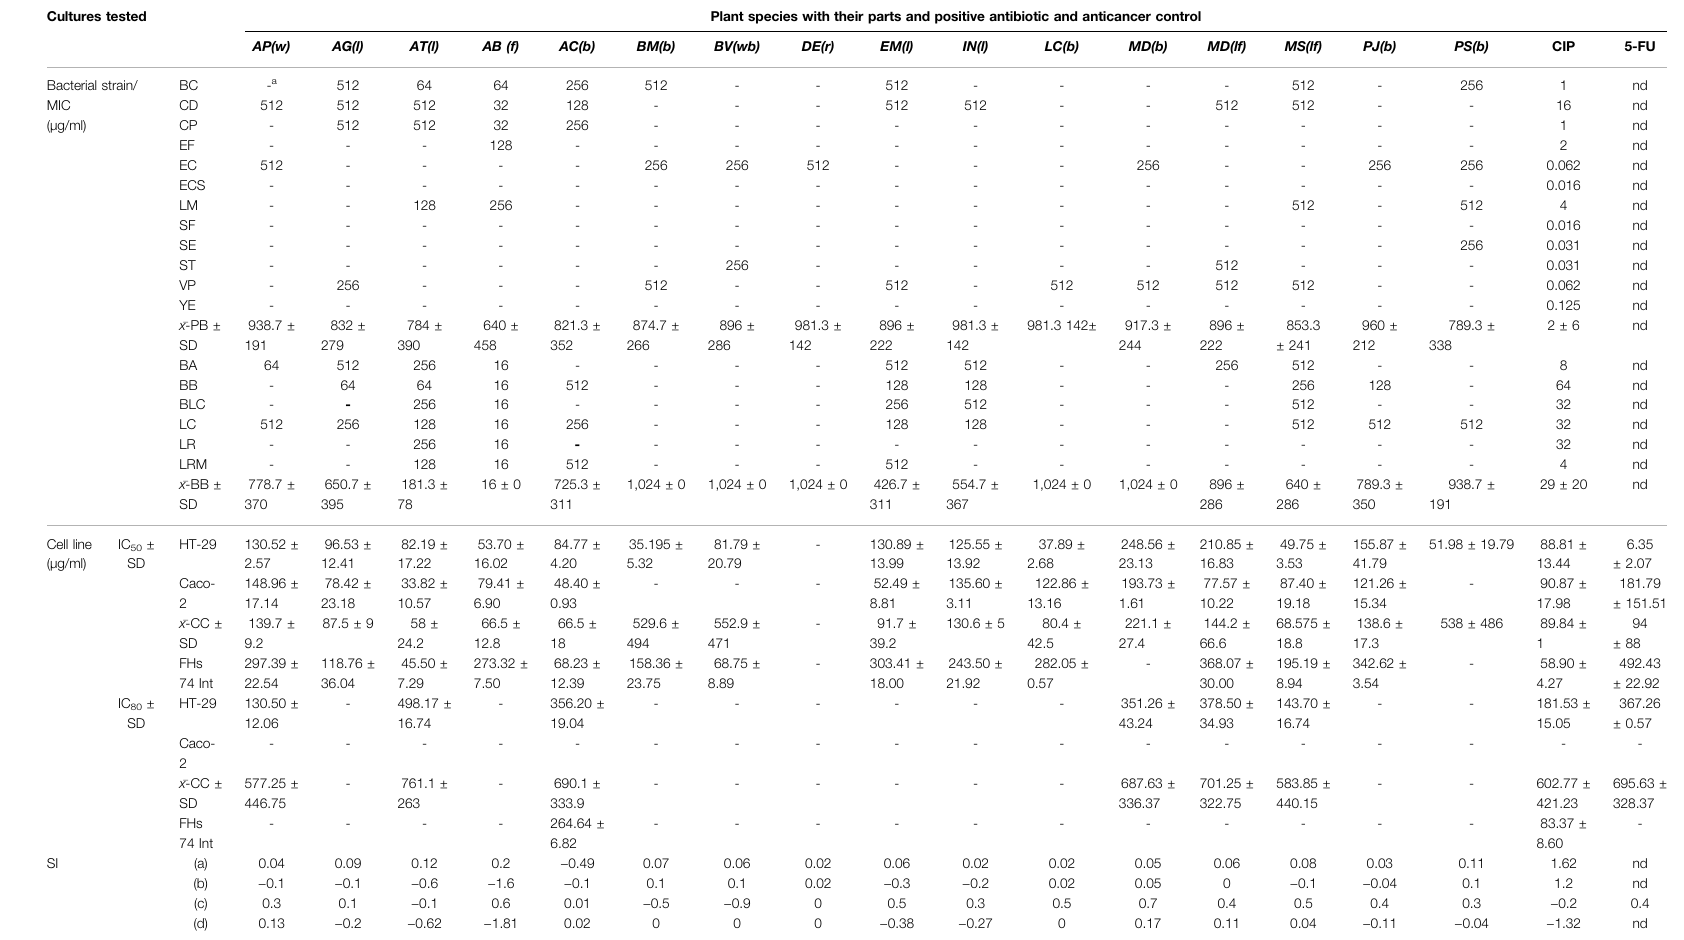
TABLE 2 | In vitro selective inhibitory activities of ethanolic extracts of Cambodian and Philippine plants against intestinal bacteria and cells. Cultures